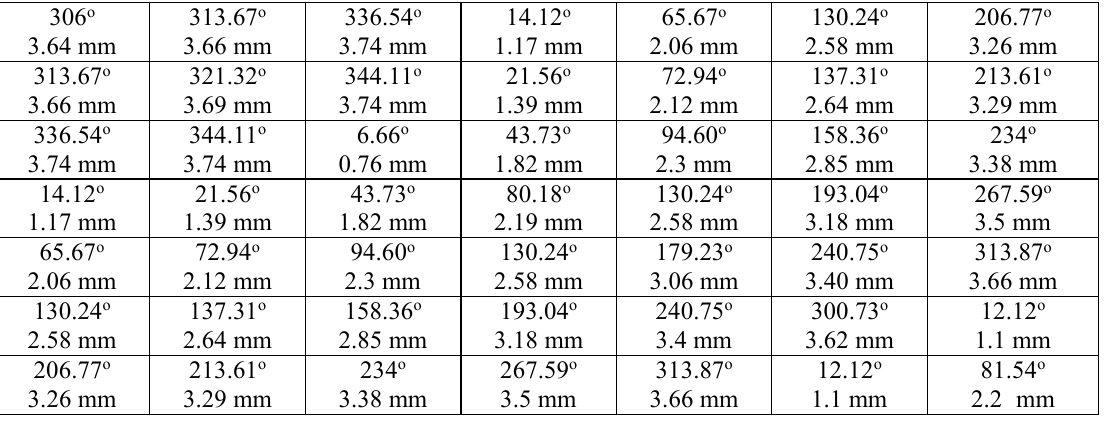
Table 1: The phase shift and the corresponding hole radius for FF and NF transmitarray (first quadrant). a. NF-focused transmitarray